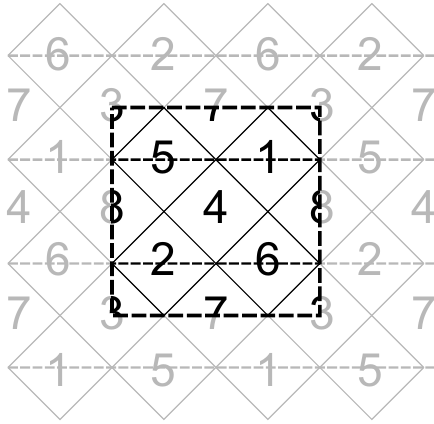
Figure 14 . Line orientifold of the dimer model for the Z 2 × Z 2 orbifold of the conifold described in text. We have highlighted a fundamental cell, and denoted dashed line the involution in which we are